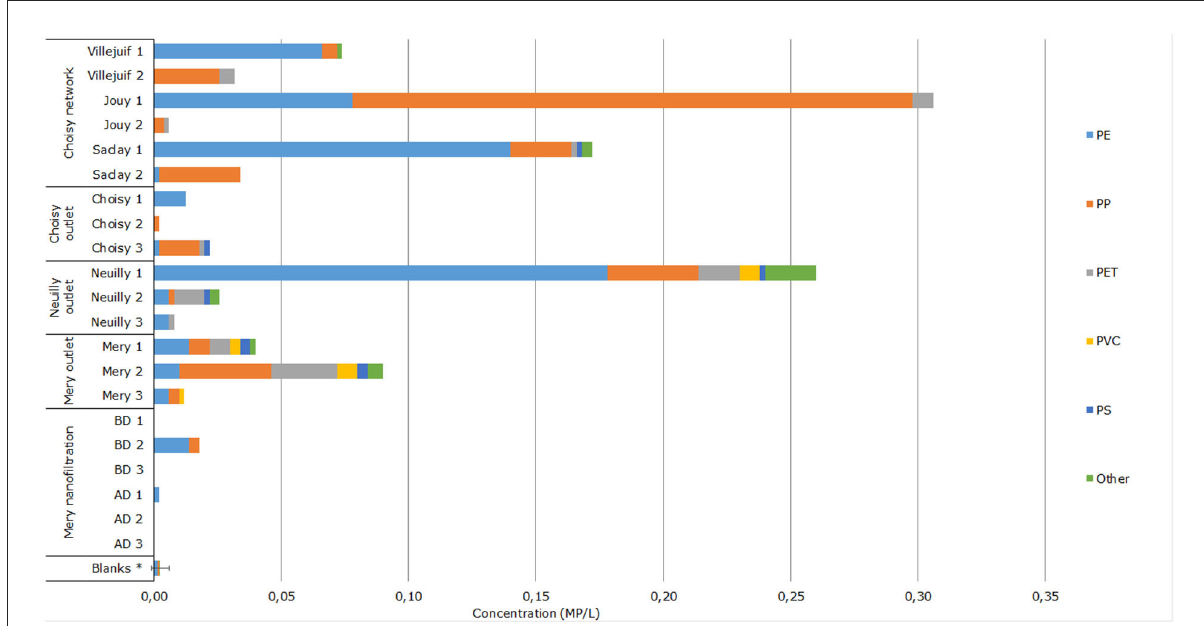
FIGURE3 Microplastic concentration and polymer distribution in outlet water and distribution network. BD, Before degassing step; D, After degassing step. * n = 12, mean ± standard